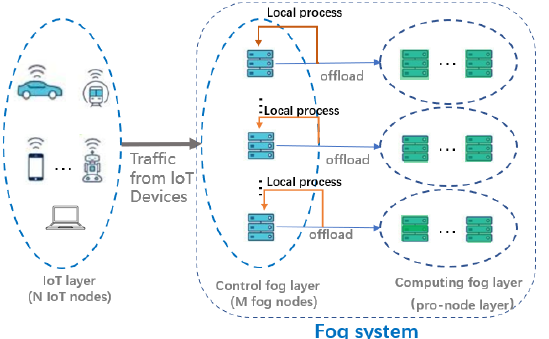
Figure 1. System model diagram indicating whether the task that comes from the IoT device is processed locally or handed over to a pro-node for processing, mainly determined by the resources required by the task. Every pro-node has S calculation subnodes.